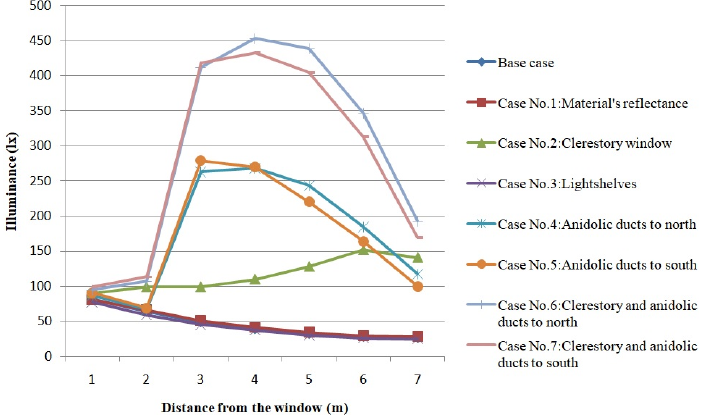
Figure 22. Comparison of average illuminance levels on the desks plane on 21 st of December at 12:00 pm.